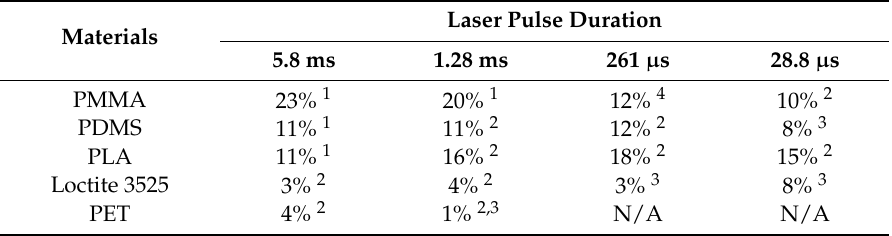
Table 1. Best aspect ratios for different plastic substrates. Superscripts are used to show the corresponding laser power density of each case.